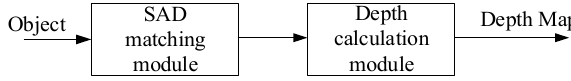
Figure 13. System architecture of the SAD-based stereo matching module.